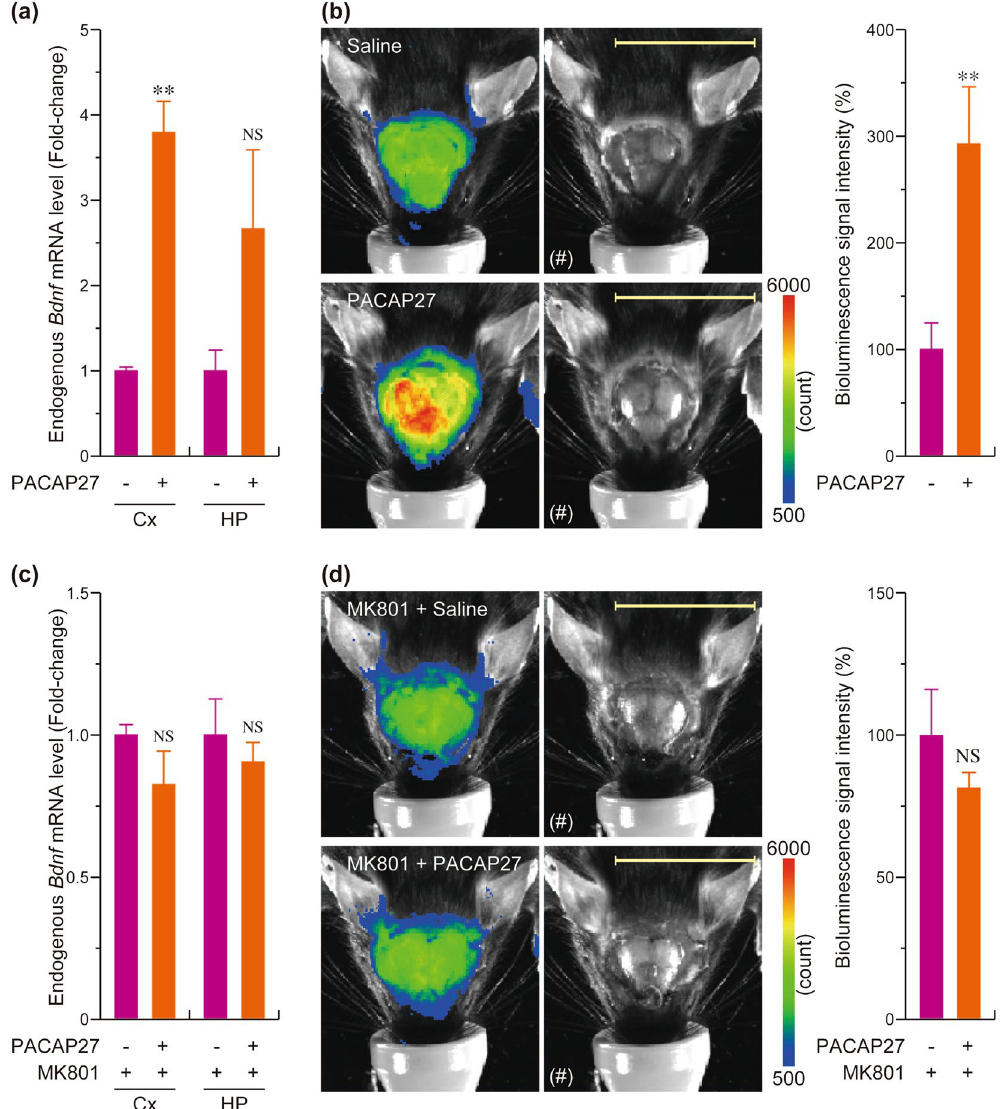
Figure 5. Detection of the increase in Bdnf expression in cerebral cortex after intracerebroventricular injection of PACAP27 by in vivo bioluminescence imaging. ( a ) Bdnf - Luc Tg mice were intracerebroventricularly administered saline or 0.1 mM PACAP27 (Injection volume: 5 μ l. Injection site: Bregma ± 0 mm, 1 mm from midline, 3 mm depth from the skull surface). Three hours after the injection, total RNA was extracted from cerebral cortex and hippocampus of the Tg mice. The expression of endogenous Bdnf mRNA was investigated by RT-PCR analysis. The data represent the mean ± S.E.M. (n = 4–5). ** p < 0.01 versus saline-injected mice. NS, not significant. ( b ) Representative images of the bioluminescence signal of Bdnf - Luc Tg mice and changes in the bioluminescence signal intensity in saline- or PACAP27-injected Tg mice. Six hours after the injection, TokeOni (75 mg/kg body weight) was administered intraperitoneally to the Tg mice, and the bioluminescence was measured by in vivo imaging (Exposure: 3 min). The data represent the mean ± S.E.M. (n = 6). The photograph of the head region (indicated by (#)) was merged with the pseudocolored image. Scale bar = 20 mm. ( c , d ) The same experiments shown in Fig. 5a and b were performed using the Tg mice pretreated with MK801. MK801 (1 mg/kg body weight) was intraperitoneally injected to the mice 30 min before the saline- or PACAP- injection. The data represent the mean ± S.E.M. (n = 3). NS, not